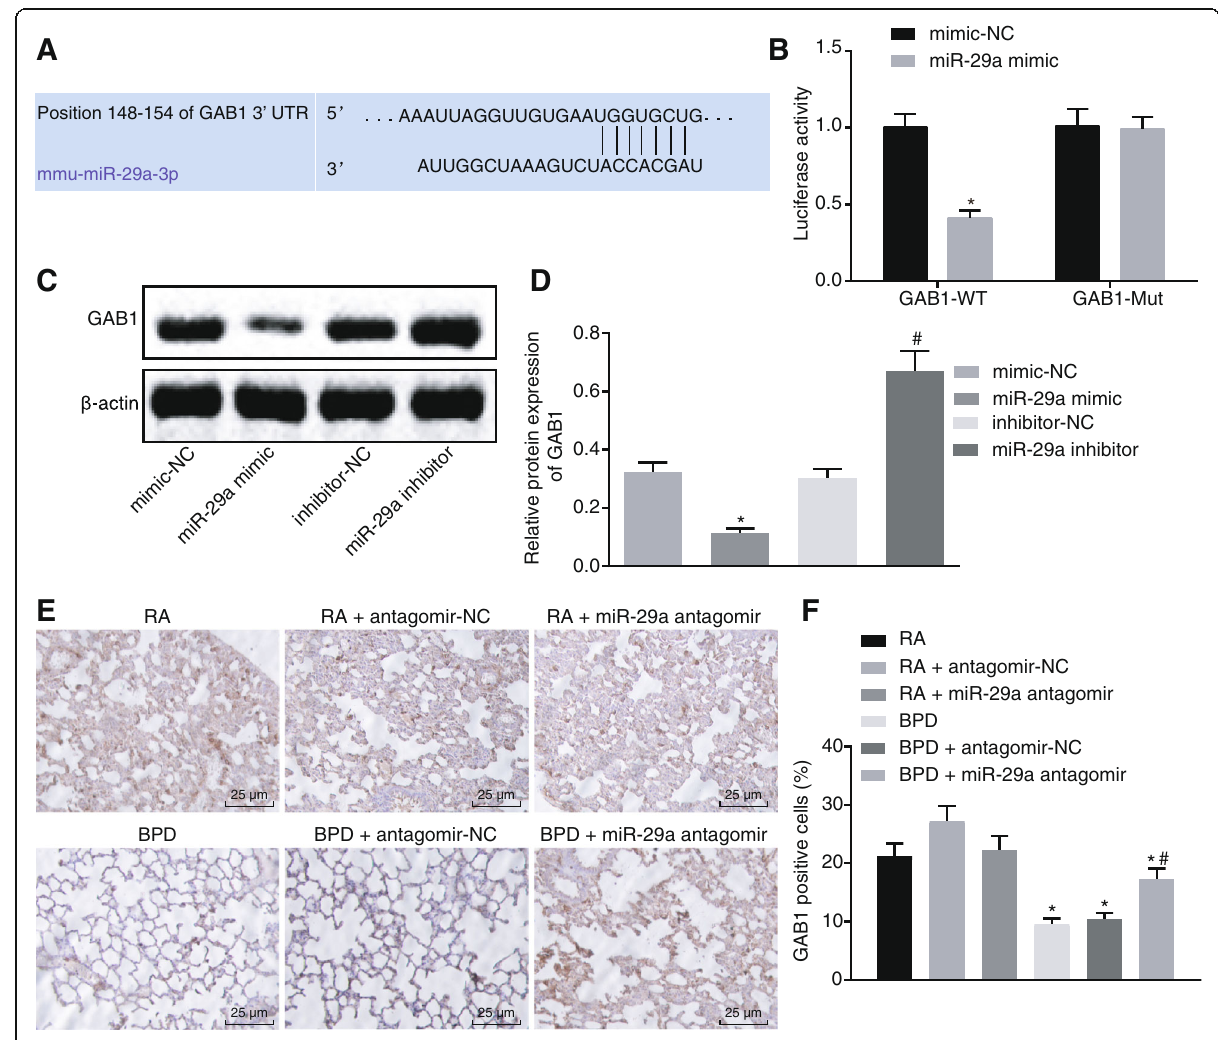
Fig. 3 GAB1 is a target gene of miR-29a. A, Predicted binding site between miR-29a and GAB1. B, The binding of miR-29a to GAB1 verified by dual-luciferase reporter gene assay. * p < 0.05 vs. the cells co-transfected with mimic-NC and pMIR-GAB1-Wt plasmids or pMIR-GAB1-Mut plasmids (the mimic-NC group). C&D, Western blot analysis of GAB1 protein in MLE-12 cells of each group. * p < 0.05 vs. MLE-12 cells transfected with mimic-NC (the mimic-NC group). # p < 0.05 vs. MLE-12 cells delivered with inhibitor-NC (the inhibitor-NC group). E&F, the positive expression of GAB1 protein in lung tissues of each group detected by immunohistochemistry (× 400). * p < 0.05 vs. neonatal mice under exposure of RA